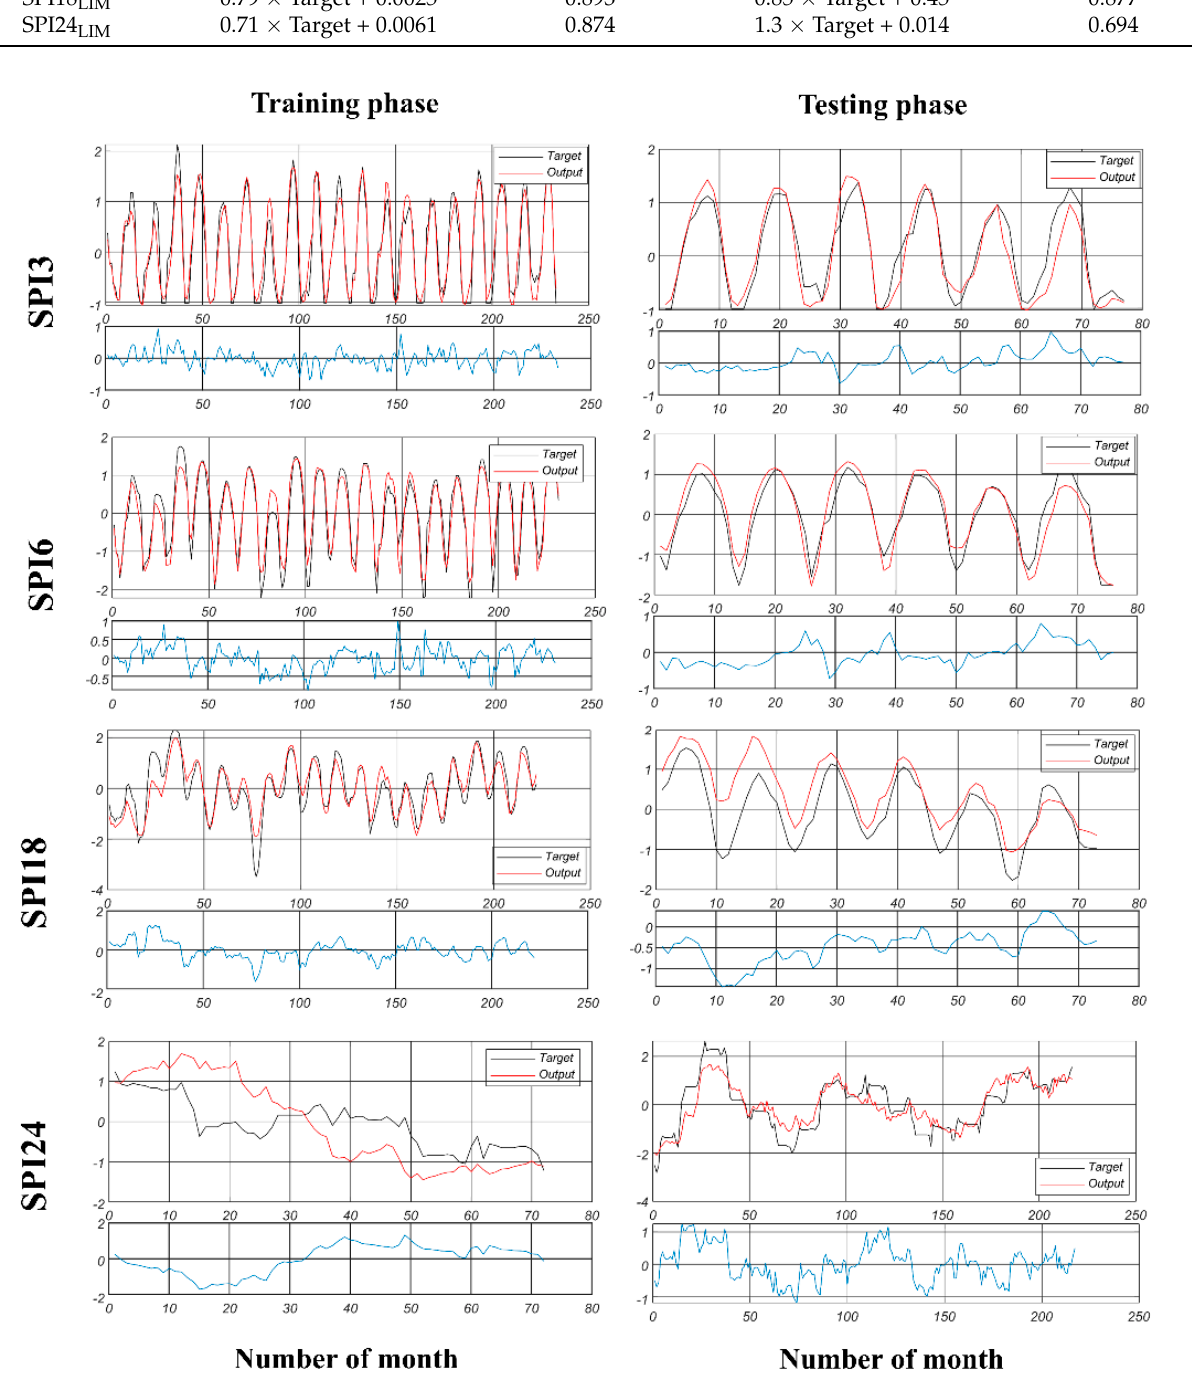
Figure 5. Time series plots of the actual and predicted SPI by proposed ANN-FA at different time